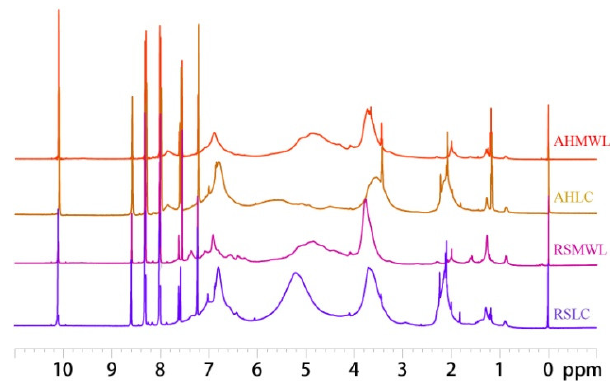
Figure 3. 1 H-NMR spectra of AHMWL, AHLC, RSMWL, and RSLC. Table 4. Methoxyl content and p -cresol introduction amount.